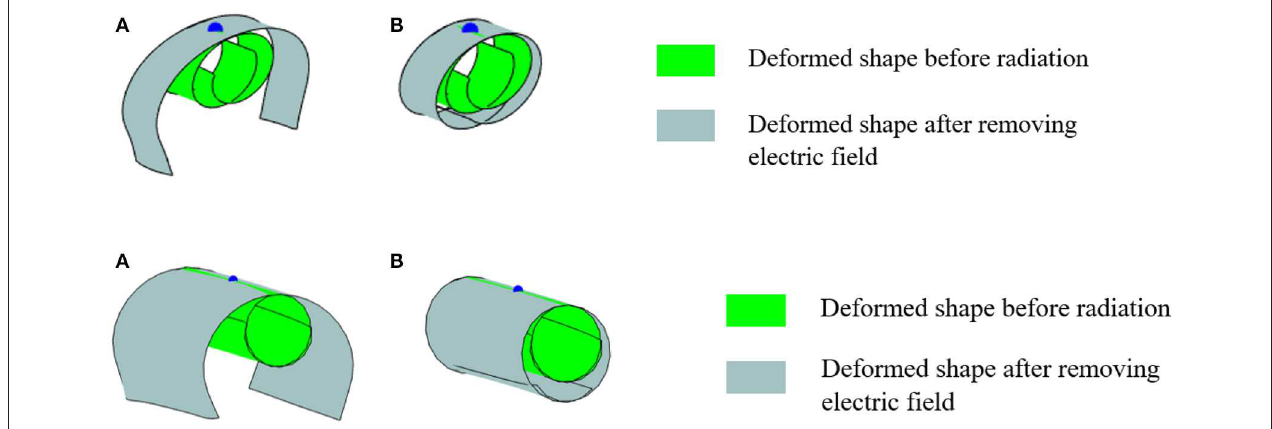
FIGURE 15 | Deformed shapes of rectangular (top) and square (bottom) bilayers, comprising of LASMP substrate, after removing electric field. (A) E ∗ s = 10 E s = 20MPa and (B) E ∗ s = 50 E s =